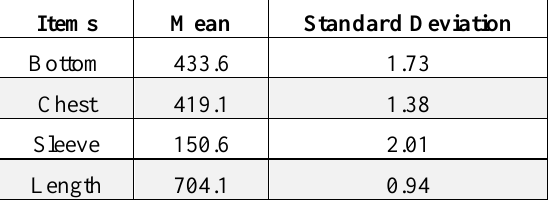
Table 5. Experimental result statistical